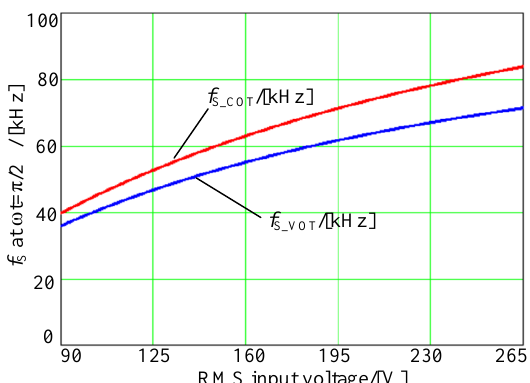
Figure 8. Comparison of the switching frequency at ωt = π/2 with different input voltage .